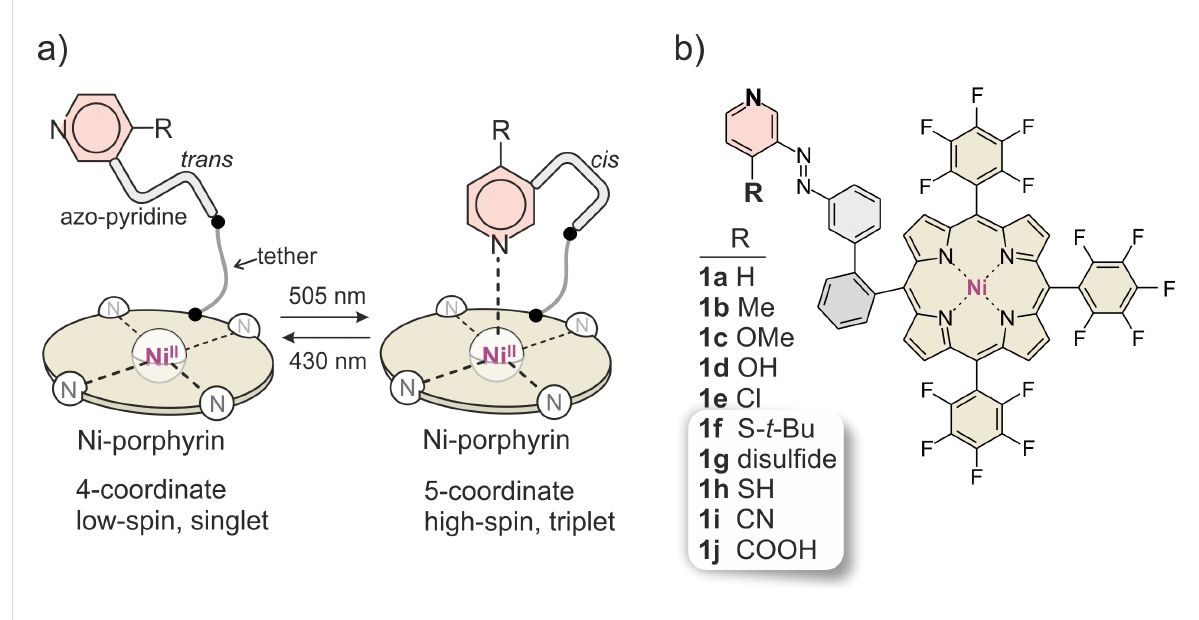
Figure 1: “Record player” approach for molecular spin switching. a) General principle b) Variation of the substituent R in 4-position of the pyridine unit. Record player molecules synthesized in this work ( 1f–j ) are highlighted.